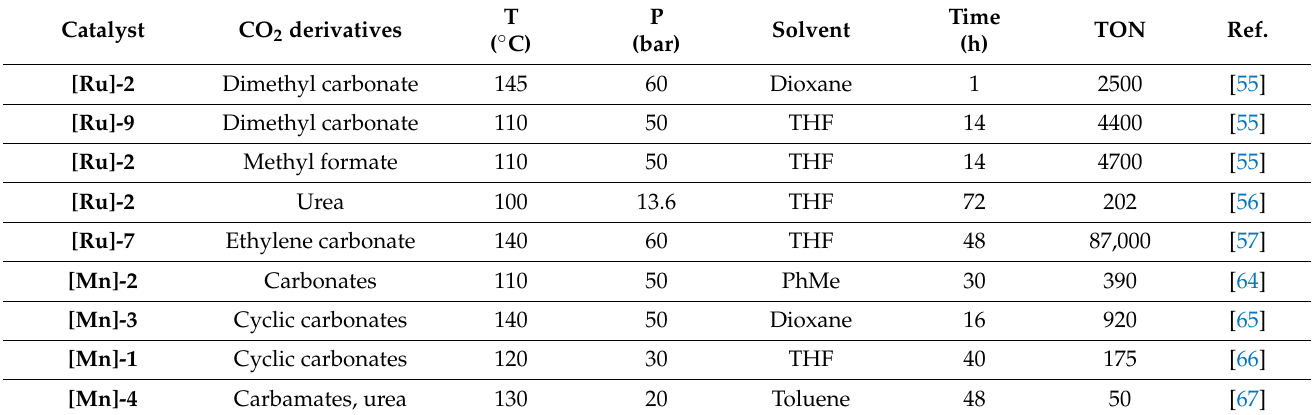
Table 2. Molecular catalysts for CO 2 derivatives hydrogenation to